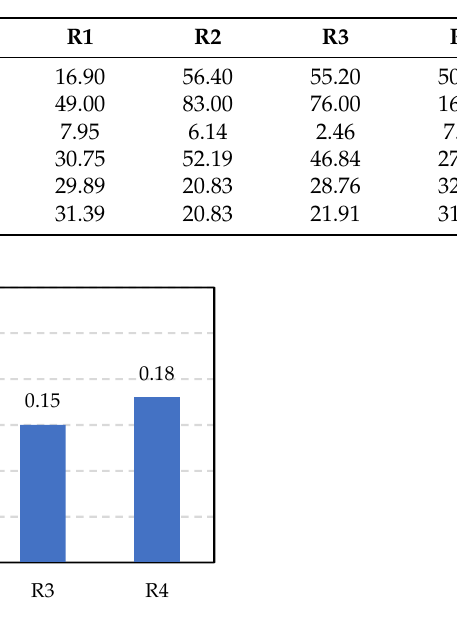
Figure 5. The comparison of RPA for the on-road test routes as well as the NEDC.